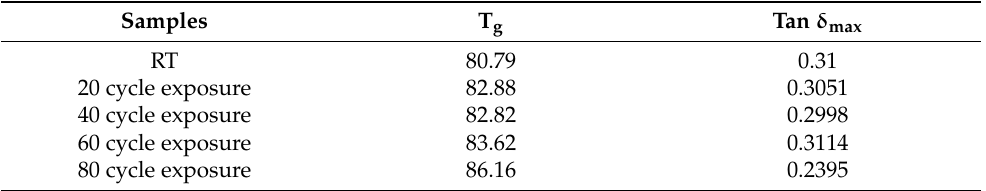
Table 3. Glass transition temperature and loss factors of RT and thermal-exposure CFRP composites.